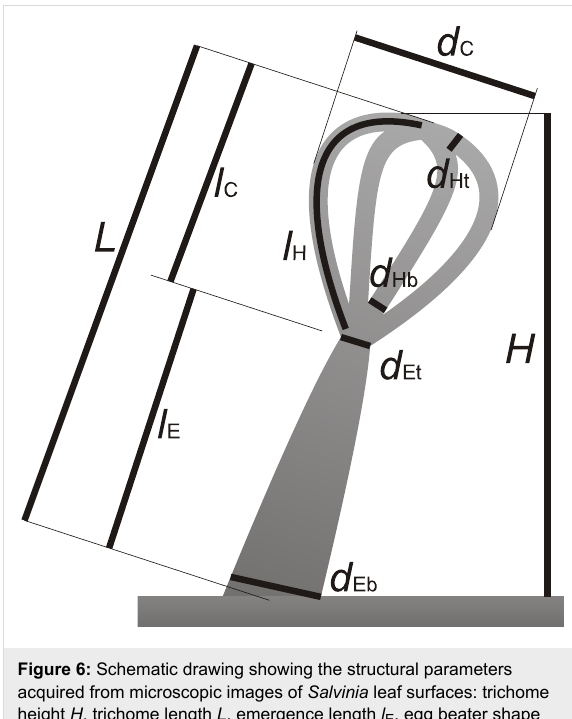
Figure 6: Schematic drawing showing the structural parameters acquired from microscopic images of Salvinia leaf surfaces: trichome height H , trichome length L , emergence length l E , egg beater shape length l C , hair length l H , emergence base diameter d Eb , emergence tip diameter d Et , egg beater shape diameter d C , hair base diameter d Hb , hair tip diameter d Ht .